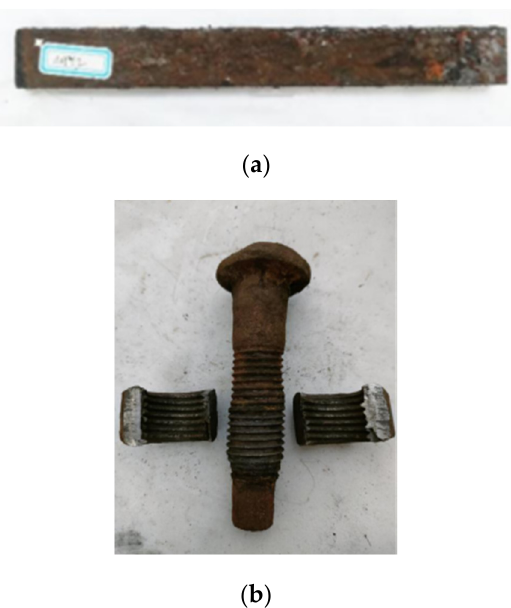
Figure 10. Corroded specimens. ( a ) Steel plate; ( b ) High-strength bolts.